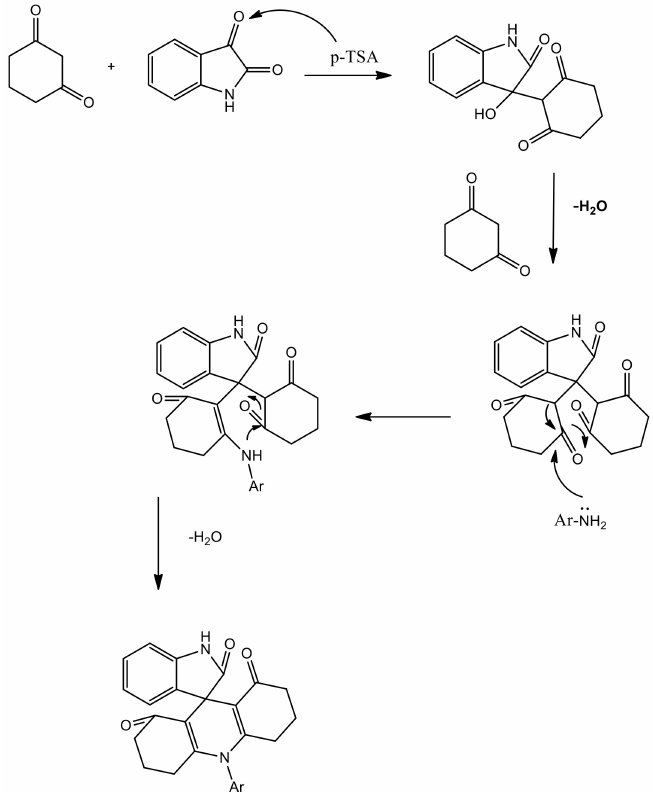
Reference 1. Gobinath, P.; Packialakshmi, P.; Daou, A.; Alarifi, S.; Idhayadhulla, A.; Surendrakumar, R. Grindstone Chemistry: Design, One-Pot Synthesis, and Promising Anticancer Activity of Spiro[acridine-9,2 (cid:48) -indoline]-1,3,8-trione Derivatives against the MCF-7 Cancer Cell Line. Molecules 2020 , 25 , 5862. [CrossRef]